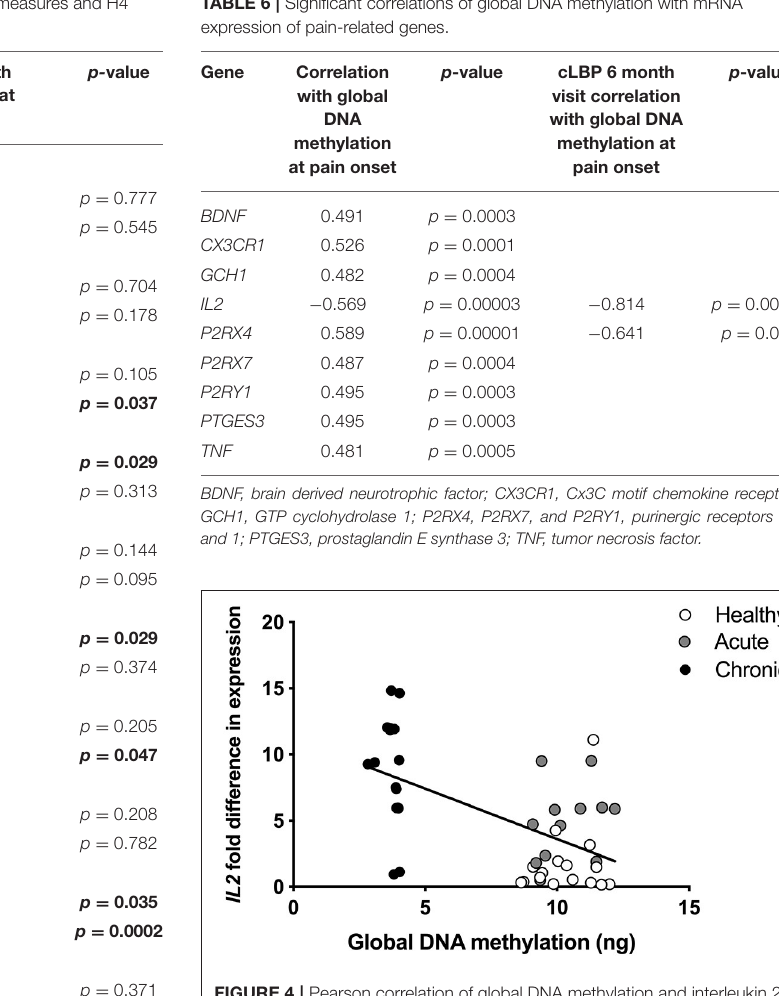
global DNA methylation (all r p > − 0.379, p < 0.05; Table 8 ). As expected, no relationship was found between BPI relief and global DNA methylation ( p =